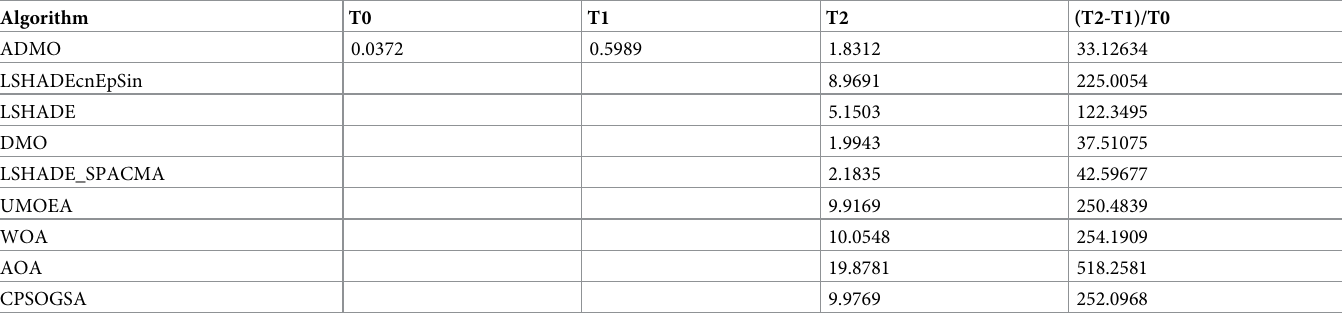
Table 2. The computational complexity for